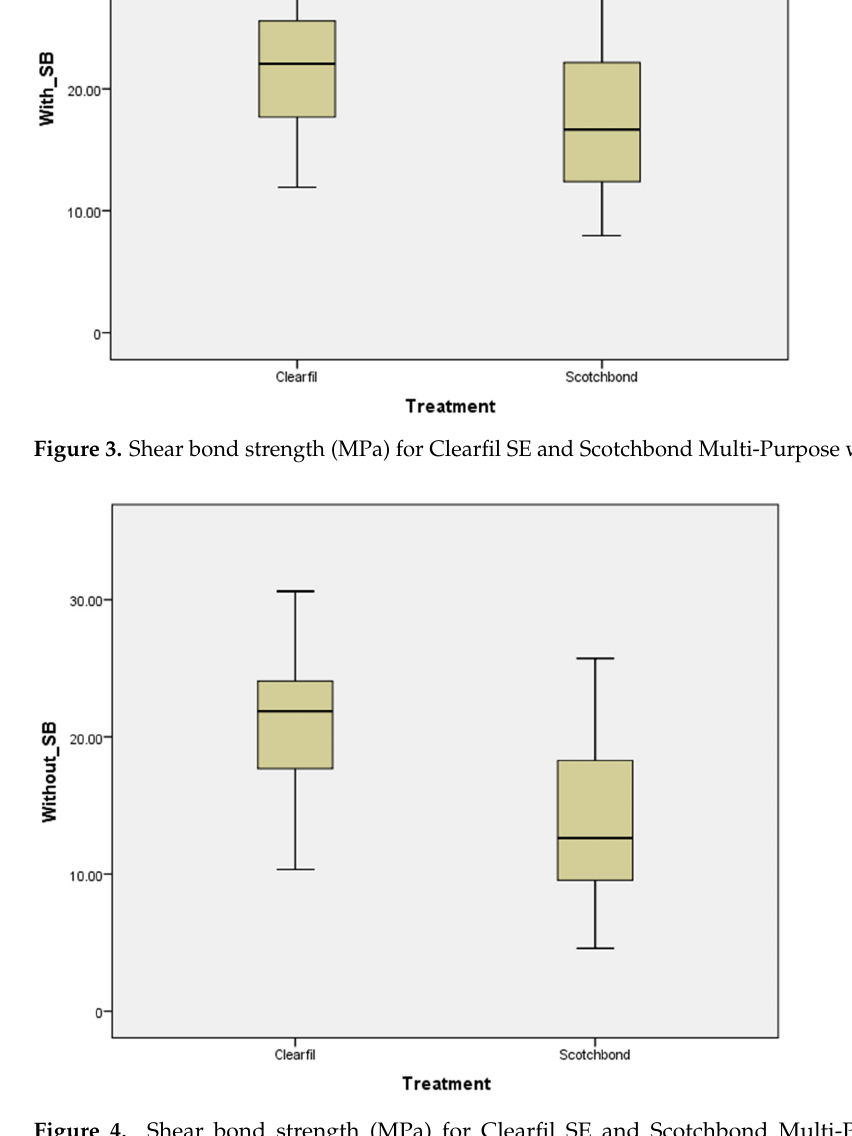
Figure 4. Shear bond strength (MPa) for Clearfil SE and Scotchbond Multi-Purpose without air